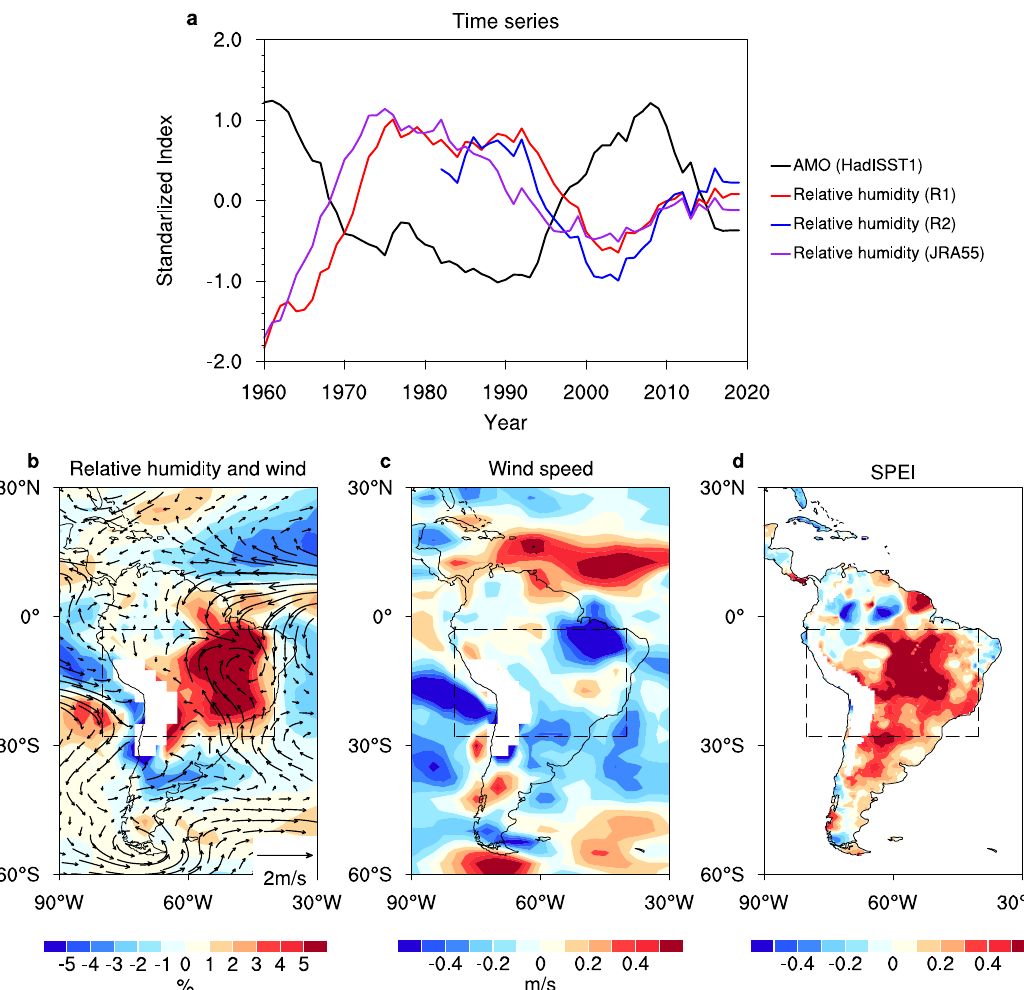
Fig. 4 Linkages among the AMO and the 925 hPa relative humidity in the SAP region. a Standardized annual mean AMO index and the 925 hPa relative humidity (from the NCEP R1, R2, and JRA55 datasets) in the SAP region during the time period 1960 – 2019 after applying the 8-year running mean. The AMO index is detrended via the Residual method. b – d Differences in the 925 hPa relative humidity, 850 hPa wind vectors, surface wind speed, and the 5-month SPEI between the negative (1969 – 1996 and 2015 – 2019) and positive (1960 – 1968 and 1997 – 2014) phases of the AMO. The linear trends for all variables in the time period 1960 – 2019 have been